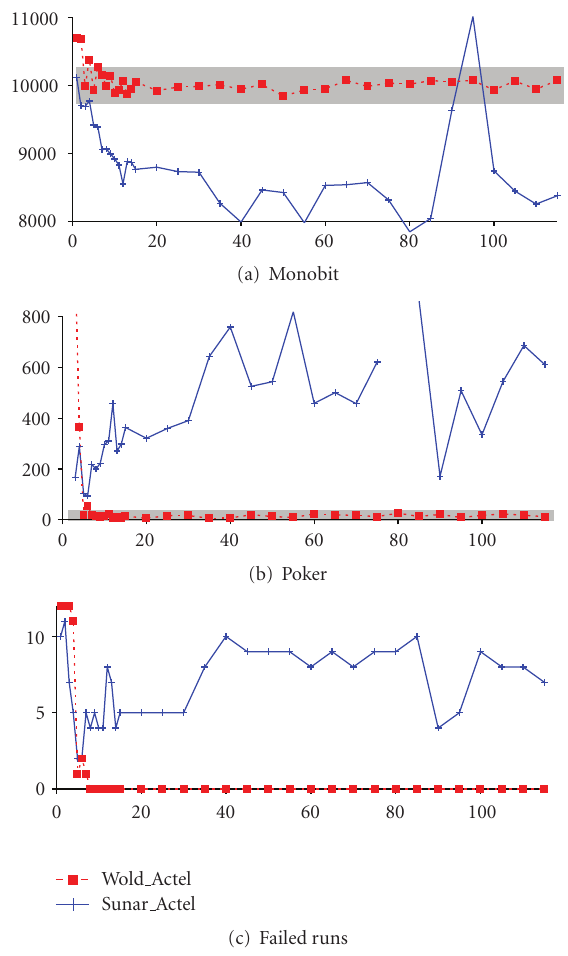
Figure 5: Results of the FIPS 140-2 tests for observed TRNG architectures with varying number of ring oscillators in Actel Fusion